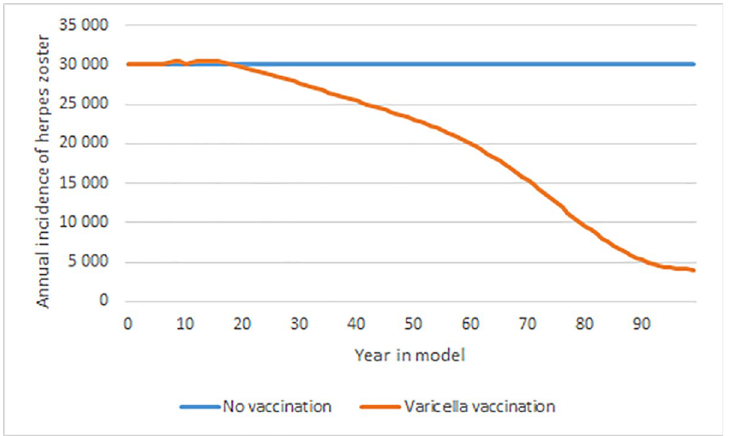
Fig 4. Annual number of herpes zoster cases with varicella vaccination. All age groups, with and without varicella vaccination, over a 100-year time horizon.